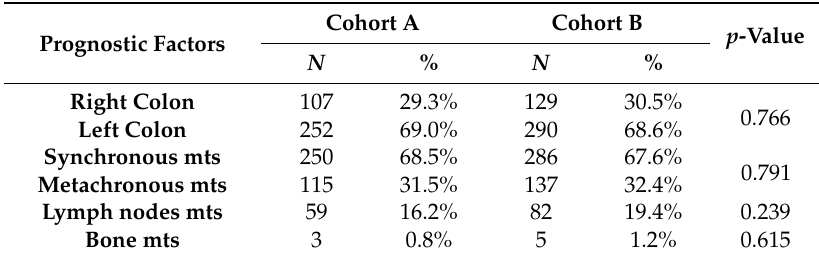
Table 6. Unfavourable prognostic factors